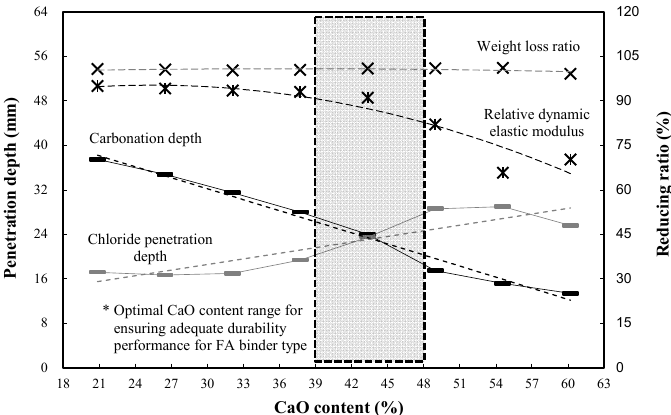
Figure 19. Optimum CaO content range of FA for ensuring adequate durability performance.